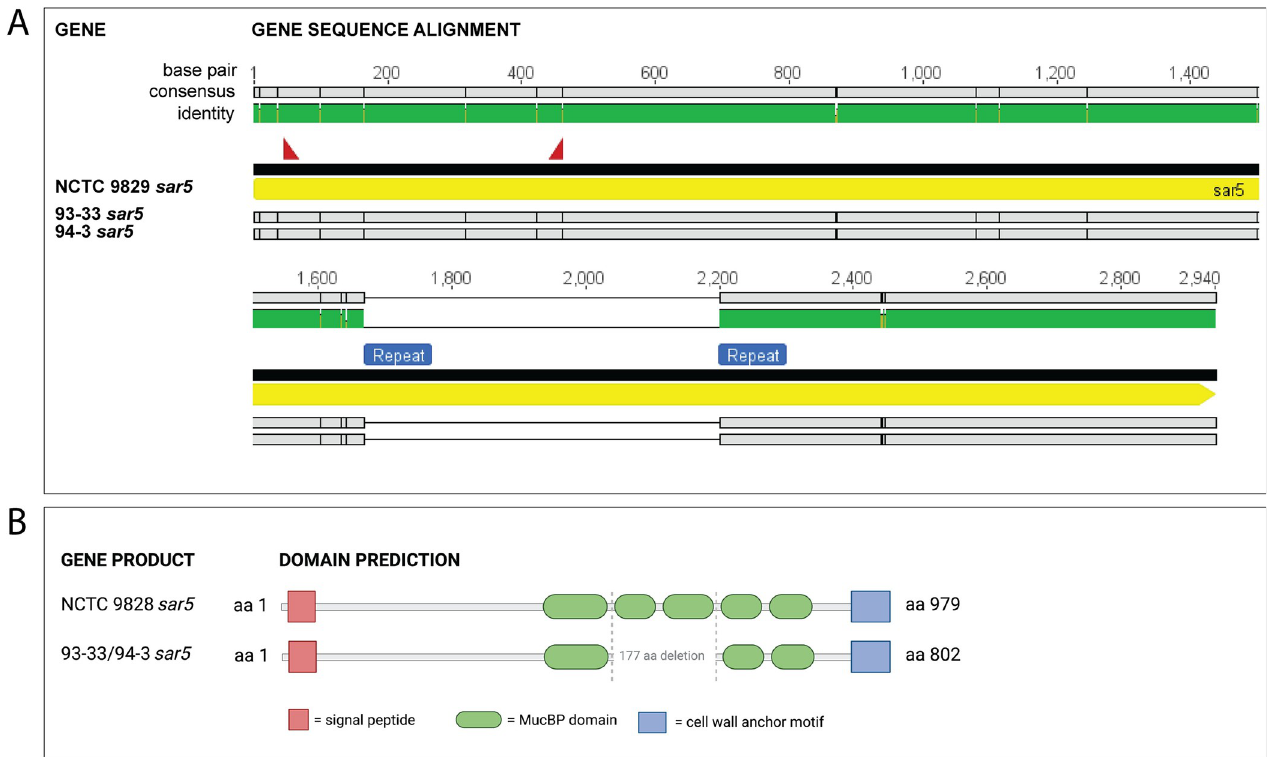
Fig 2. (A) Alignment of the gene sequences of strains 93–33 and 94–3 to the sar5 gene of sar5 reference strain NCTC 9828. Identity between all sequences is indicated by the top panel in green and gene annotation is shown in yellow. Black vertical lines indicate mismatches at the nucleotide level, while grey boxes indicate matching nucleotides to the reference strain. 93–33 and 94–3 have a 531 bp long deletion (marked with horizontal line) within the sar5 gene. The binding sites of the primers used to detect the sar5 gene are shown as red triangles. Repeat regions are shown in blue. (B) Pfam database prediction of protein domains and motifs of the gene products encoded by sar5 of strains NCTC 9828 and 93-33/94-3 (figure created with